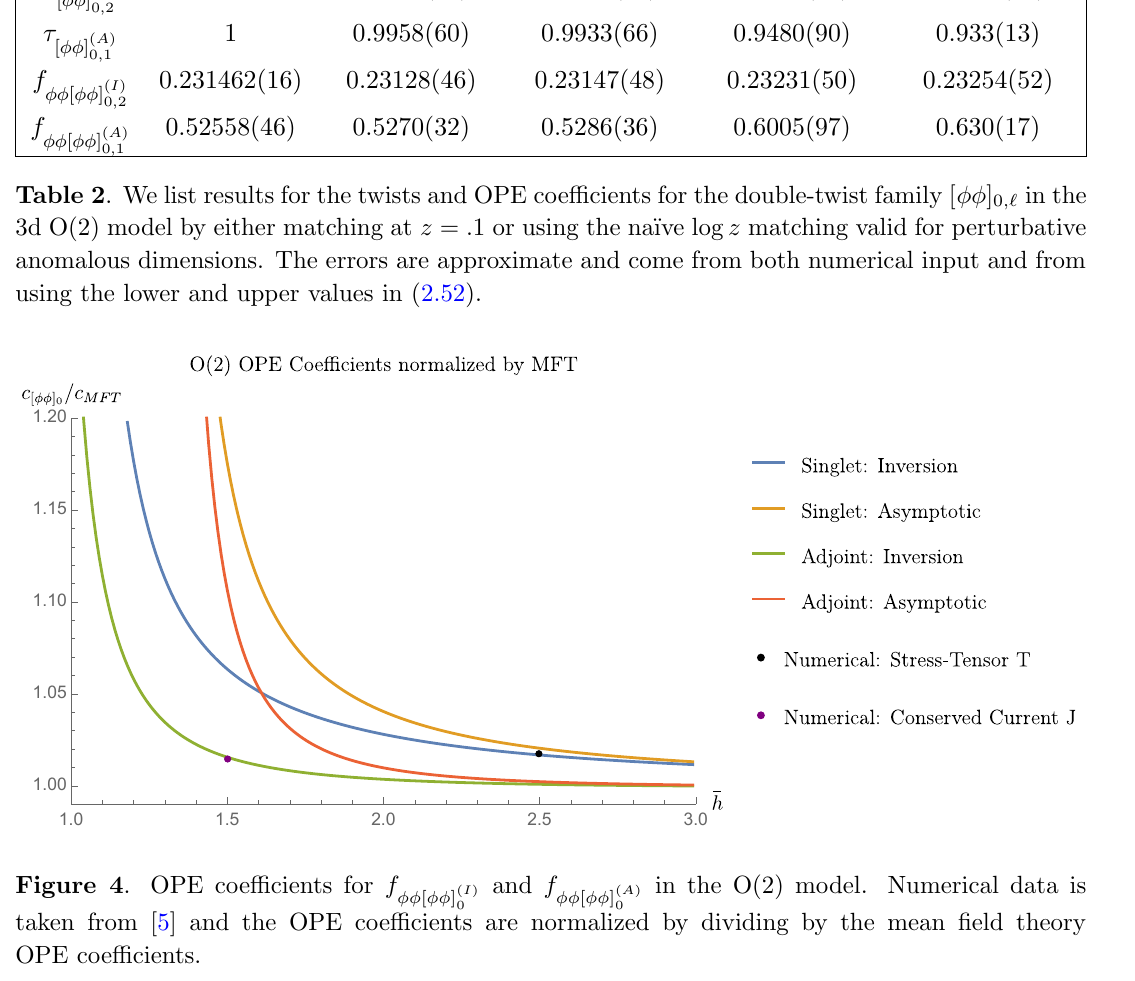
and f in the O(2) model. Numerical data is φφ [ φφ ] ( I ) 0 φφ [ φφ ] ( A ) 0